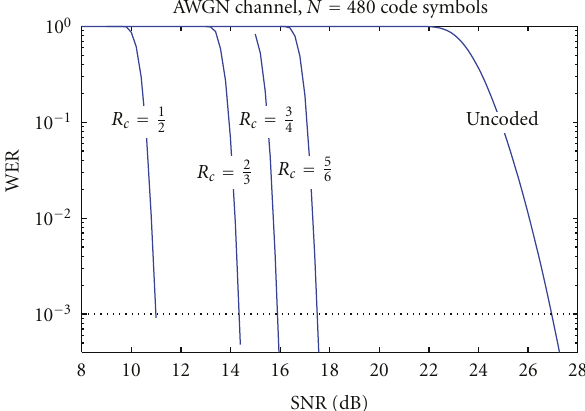
Figure 9: Word error rate (WER) for nonbinary LDPC codes at various rates. The high slopes of the curves allow to define thresholds for the various rates, such that a very low word error rate ( < 10 − 3 ) is achieved beyond the threshold, while it rapidly increases before such